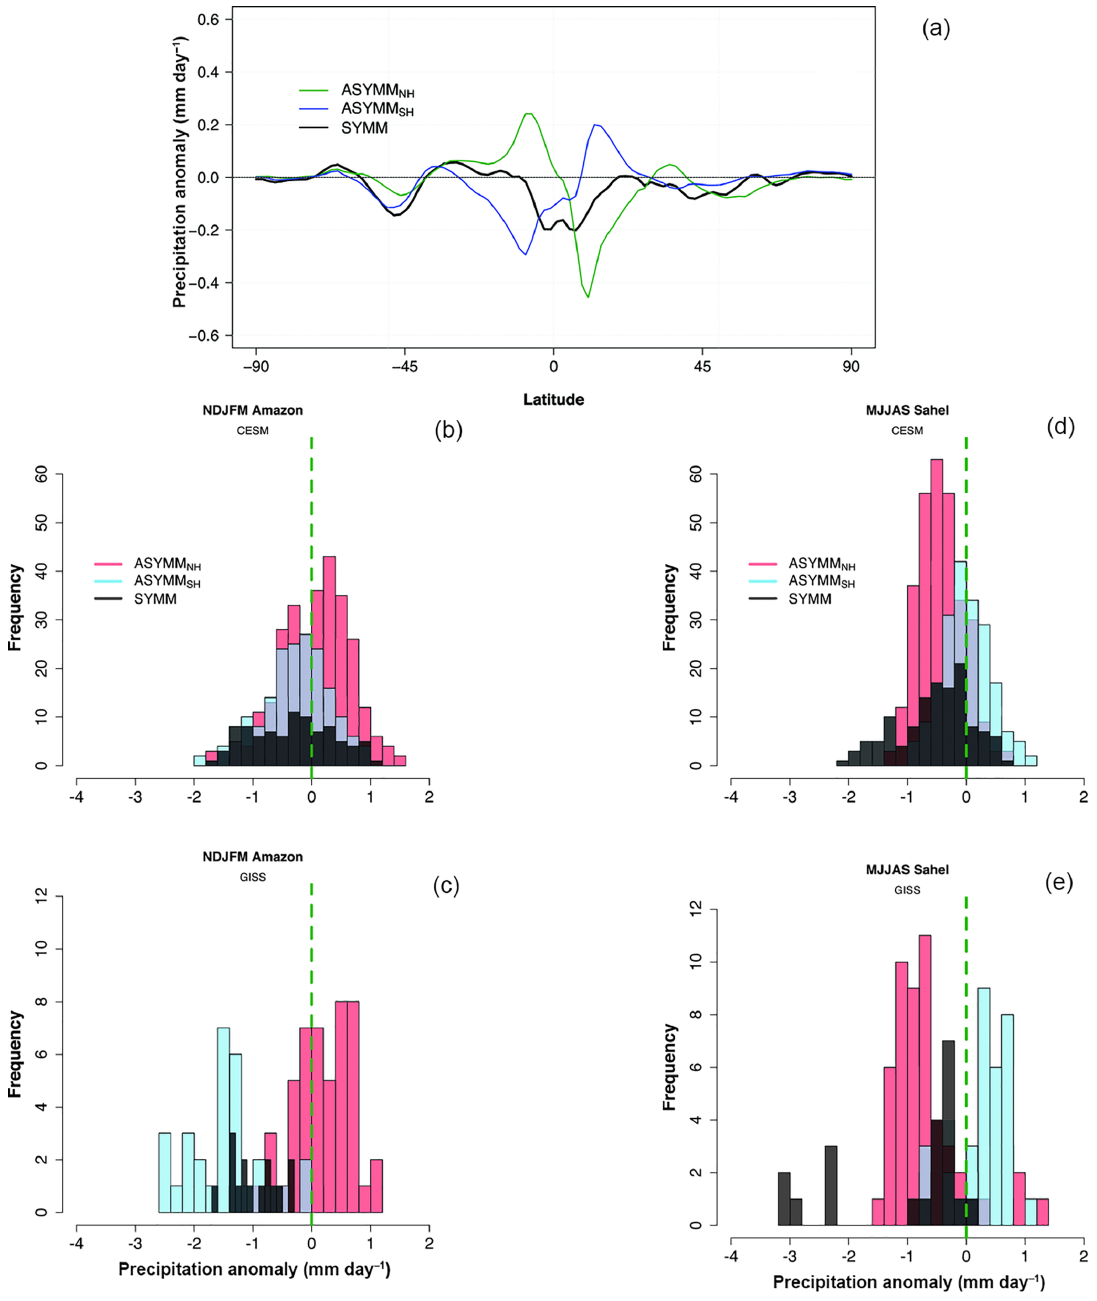
Figure 6. (a) Composite zonal mean precipitation anomalies (mmday − 1 ) following volcanic eruptions with hemispherically symmetric loading (black) and for preferential aerosol loading in the NH (green) and SH (blue). The grouping of eruption categories follows the methodology in Colose et al. (2016b) and results are shown for all-inclusive eruptions within 18 ensemble members in CESM LME. (b) Histogram showing frequency of precipitation response in CESM LME during the NDJFM season over the Amazon and (d) MJJAS in the Sahel. Results are for all NH eruptions (red), SH eruptions (aqua-blue), and symmetric events (black). Panels ( c ) and ( e ) are as in ( b ) and ( d ) except using NASA GISS ModelE2-R with three ensemble members and larger forcing. Note that the forcing implementation in this version used the spatial structure in Gao et al. (2008) but with approximately 2 times the appropriate radiative forcing, as described in the